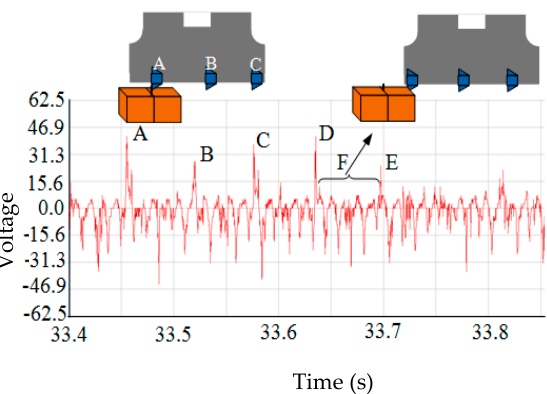
Figure 2. Thermoelectric potential signal diagram of the milling process measured by the e x − periment.